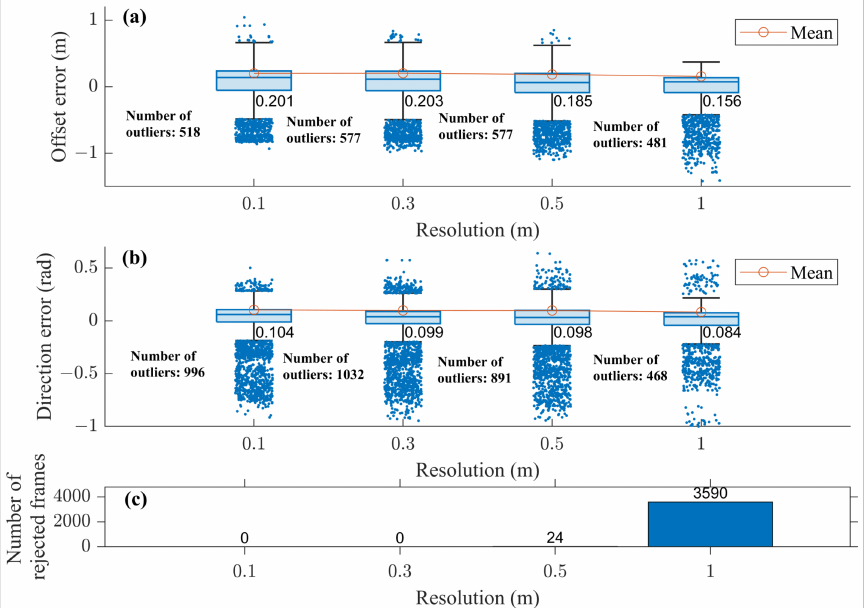
Figure 19. Error of proposed method for dataset 1 under different map resolutions: ( a ) offset error; ( b ) direction error; ( c ) number of rejected